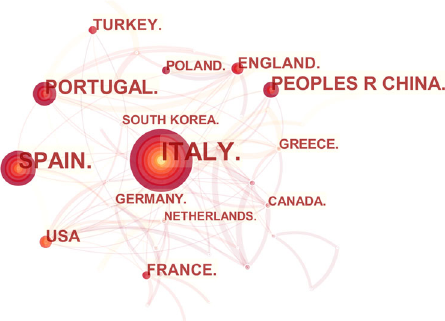
Fig. 4 Geographical distribution of HBIM studies. Geographical distribution of HBIM studies analyzed by CiteSpace bibliometric analysis